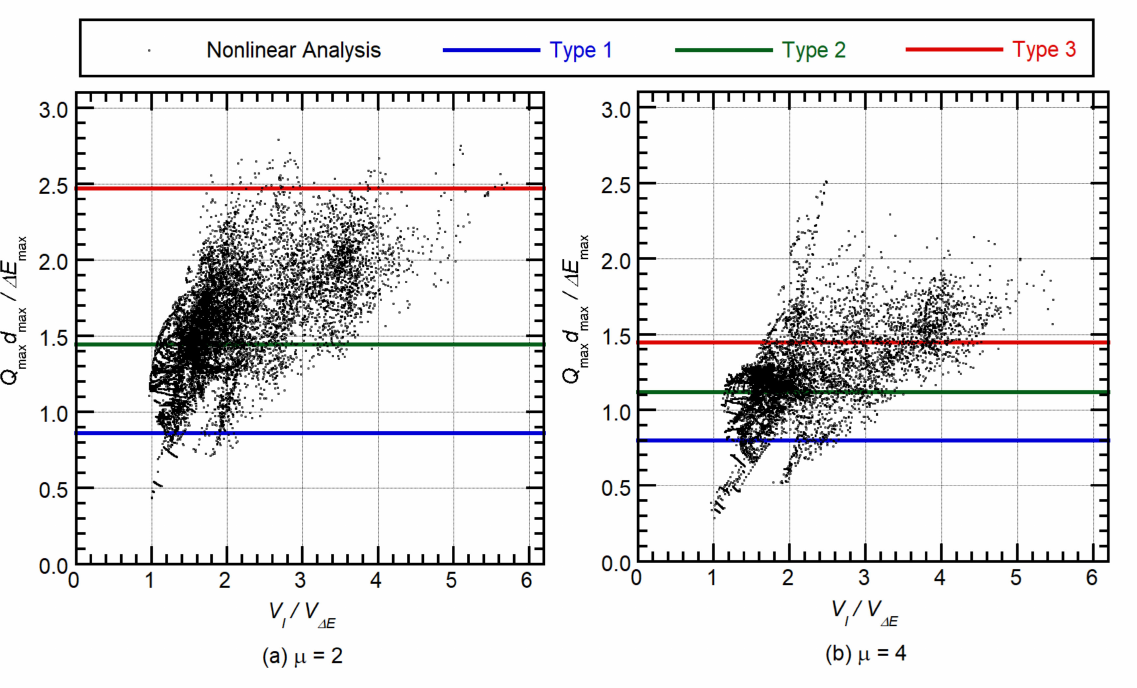
Figure 11. Relationship between V I / V ∆ E and Q max d max / ∆ E max obtained from nonlinear time-history